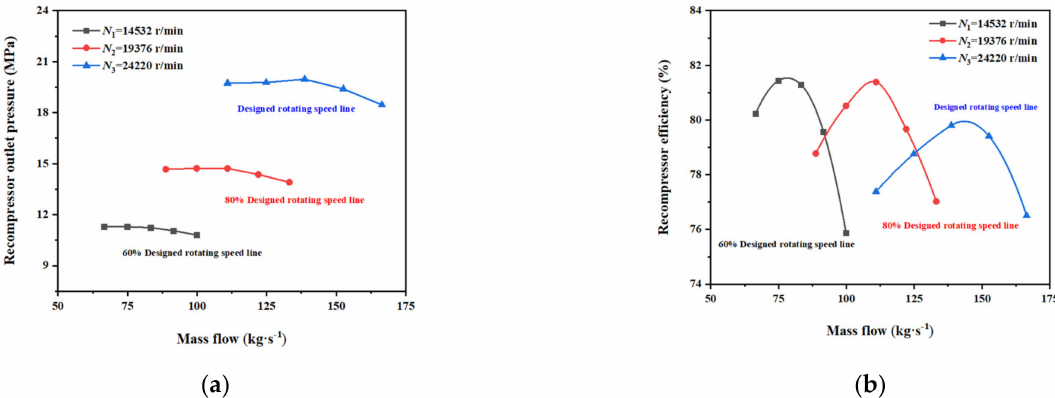
Figure 4. The performance prediction curves of the recompressor. ( a ) Outlet pressure prediction of RC. ( b ) Efficiency prediction of